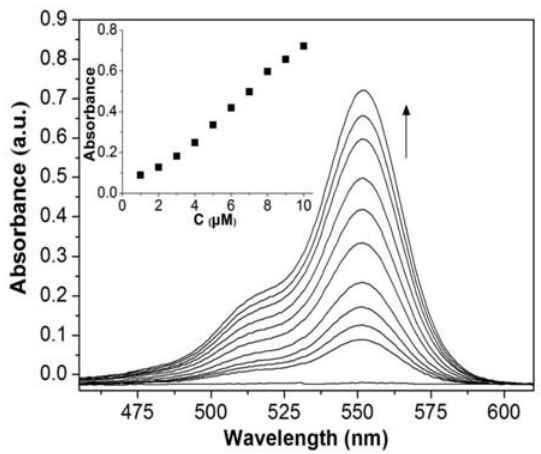
Figure 5. UV-vis spectra of RD (10 μM) in the presence of diffe- rent concentrations of Cu 2+ (0–10 μM) in MeCN-H tion. Inset: absorbance as a function of Cu 2+ concentration.